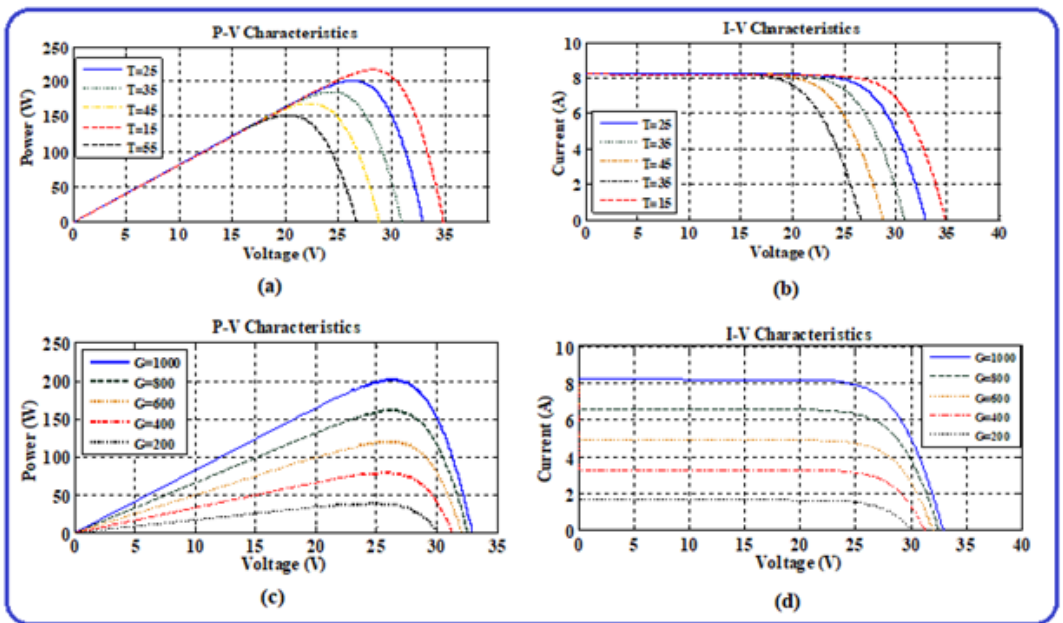
Figure 3. Characteristics of solar PV module at varying temperatures and varying irradiances. ( a ) P-V characteristics at varying temperatures ( b ) I-V characteristics at varying temperatures ( c ) P-V characteristics at varying irradiances ( d ) I-V characteristics at varying temperatures irradiances.